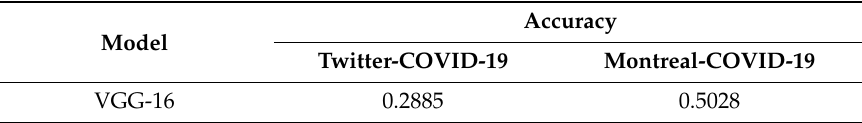
Table 6. Performance metrics achieved in classifying the Twitter- and Montreal-COVID-19 CXR collections as showing viral